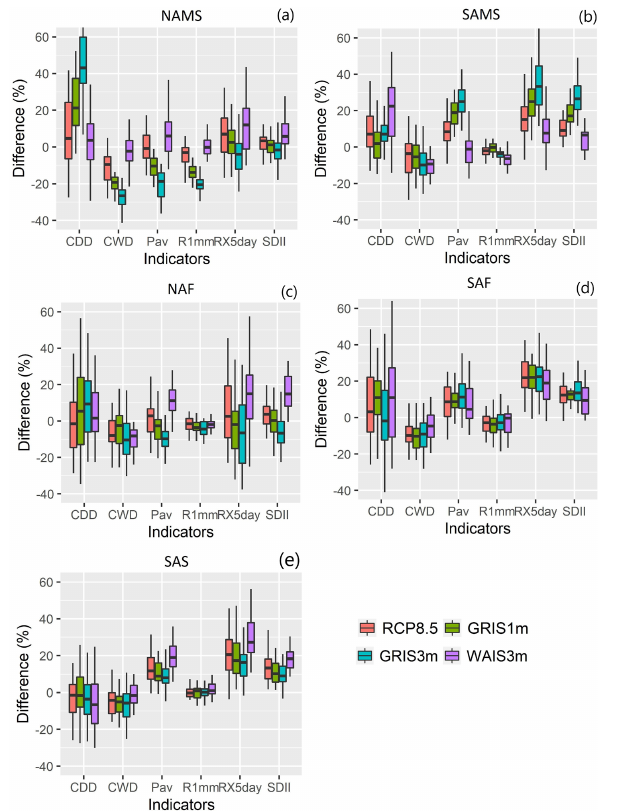
Figure 10. Comparison of the inter-annual variability of each land monsoon index for the future period (2041–2070) with the aver- age of the historical period (1976–2005) for (a) NAMS, (b) SAMS, (c) NAF, (d) SAF and (e) SAS as well as for each simulation. RCP8.5 is shown in red, GrIS1m in green, GrIS3m in blue and WAIS3m in